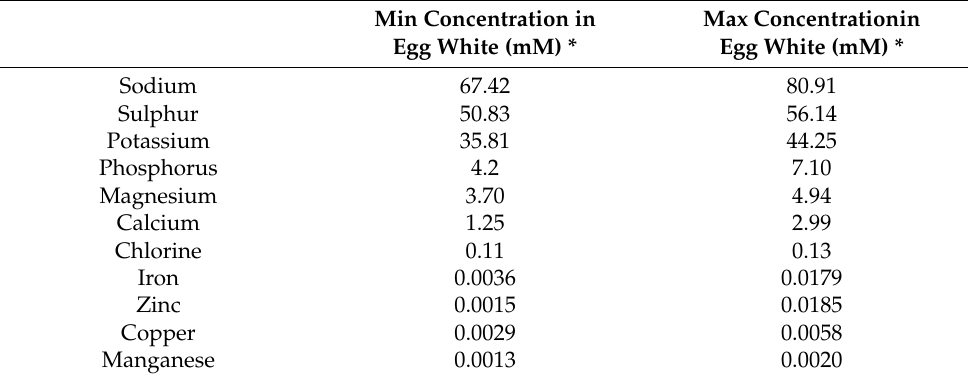
Table 1. Mineral composition of egg